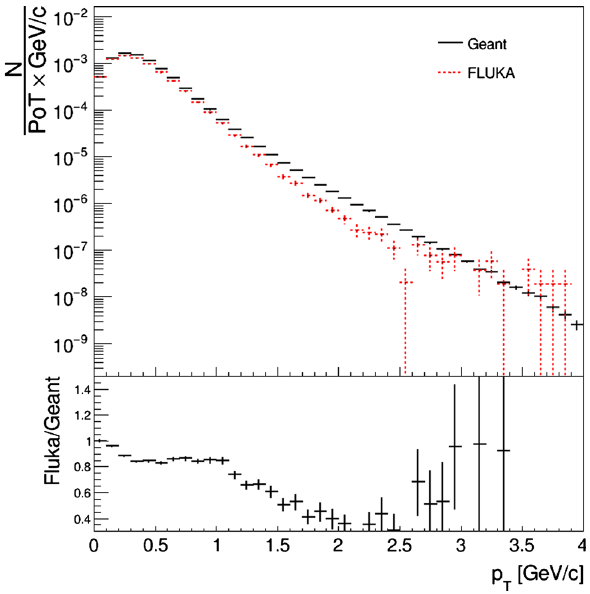
Fig. 11 Transverse momentum distributions from FLUKA and GEANT4. The distributions are normalized to the number of